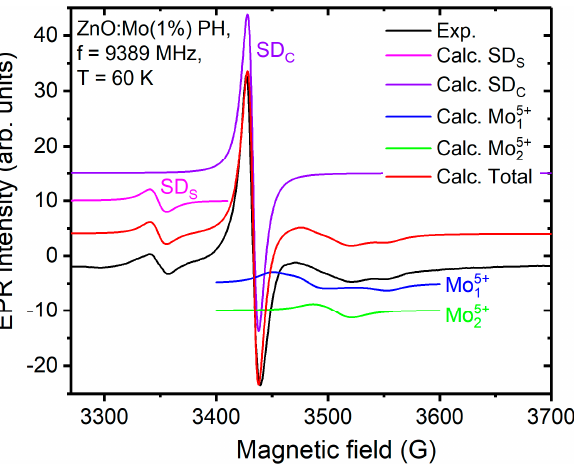
Figure 4. Experimental EPR spectrum measured in the ZnO:Mo(1%) PH sample. The signals calculated to fit the experimentally observed ones are indicated in the figure and in the legend.